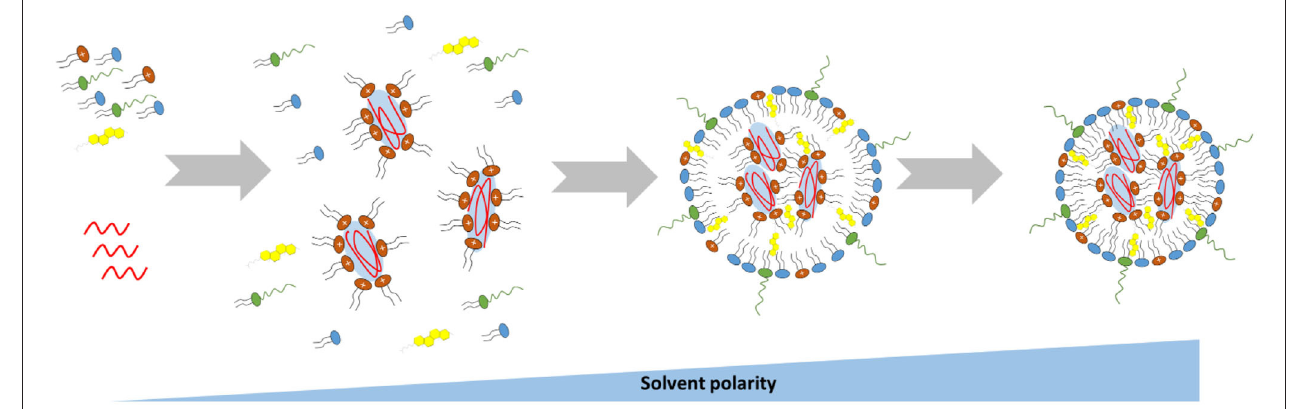
FIGURE 5 | Schematic representation of the mechanism driving the self-assembly of mRNA-loaded lipid-based nanoparticles.